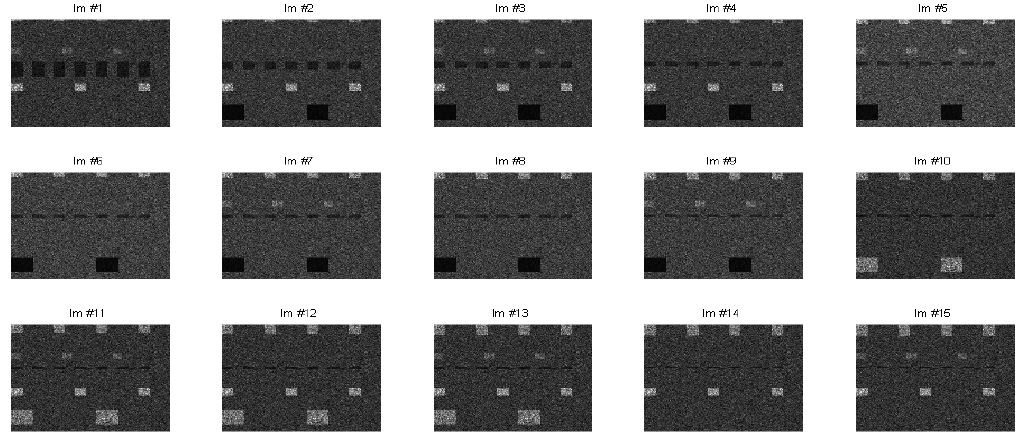
Figure 2. Simulated SAR images time series (15 images).